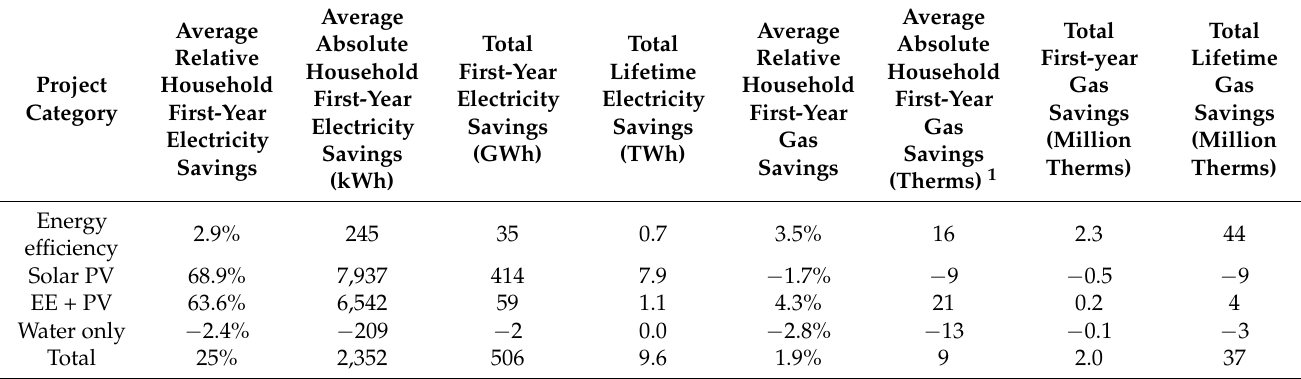
Table 6. Estimated R-PACE program first-year and lifetime